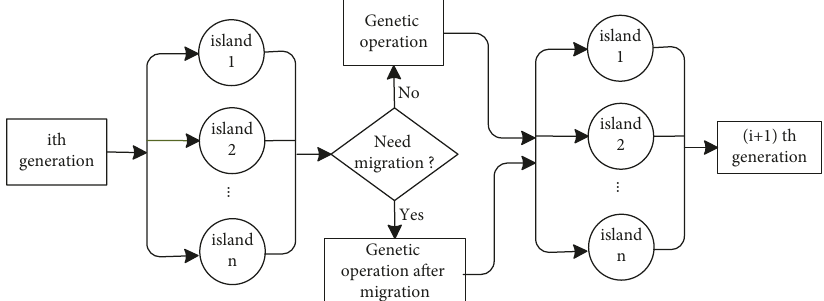
Figure 1: The evolution process of two successive generations of